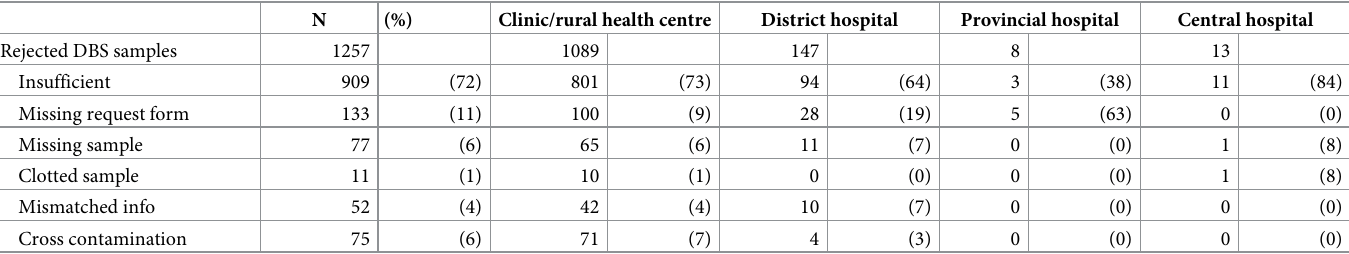
Table 3. Proportion of DBS samples rejected at the NMRL between January and December 2017, rejection reason and type of health facility.